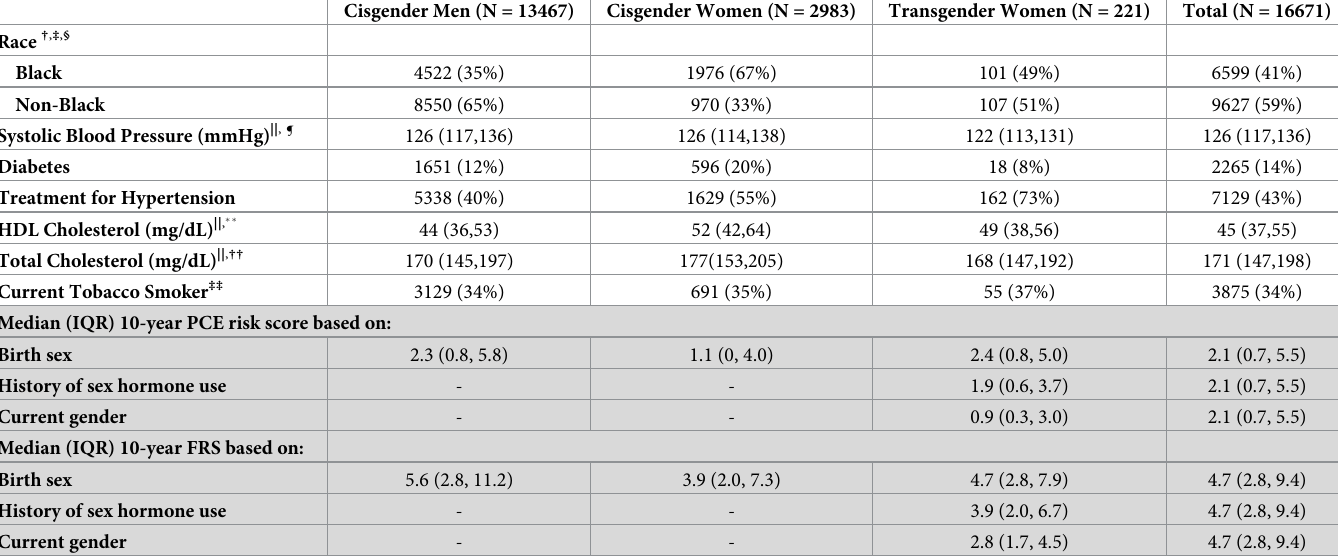
Table 2. CVD risk score predictors and median and IQR of CVD risk score among 16,671 Adults Alive and in Care at a CNICS Site as of the Site-Specific Adminis- trative Censoring Date, October 2014-February 2018 � . Cisgender Men (N = 13467) Cisgender Women (N =